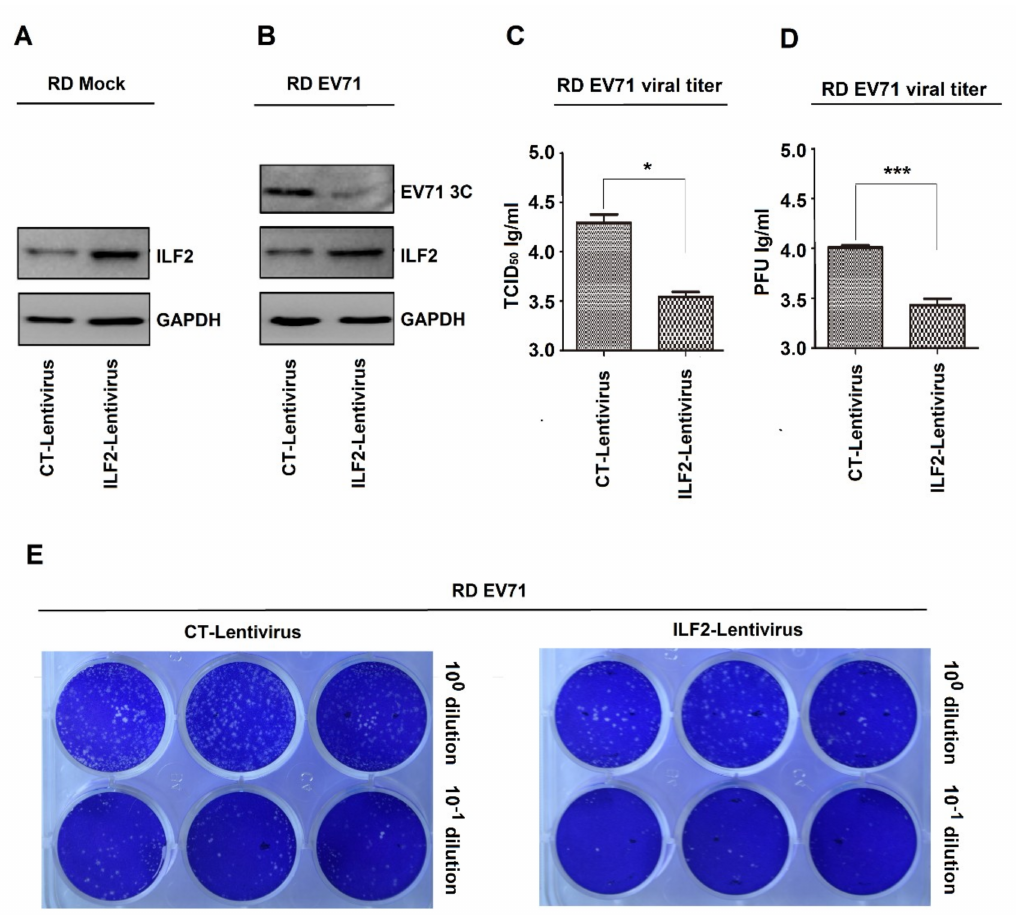
Figure 1. ILF2 represses EV71 infection in RD cells. ( A ) RD cells infected with the recombinant lentiviruses, ILF2 lentivirus expressing ILF2 and its control CT lentivirus, to generate two stable cell lines. ILF2 and GAPDH proteins expressed in the lysates of stable cell lines were detected by Western blot analysis. ( B ) The two stable cell lines infected with EV71 (MOI = 0.5) for 12 h. ILF2, EV71 3C, and GAPDH proteins expressed in the lysates of stable cell lines were detected by Western blot analysis. ( C – E ) The stable cell lines infected with EV71 (MOI = 0.5) for 12 h, and the supernatants of cell cultures collected and then inoculated into Vero cells. ( C ) The levels of EV71 TCID50 determined by TCID50 assays. ( D ) The levels of EV71 PFU determined by plaque assays. ( E ) Data presented in ( C ) and ( D ) visualized under a camera. * p < 0.05, and *** p <